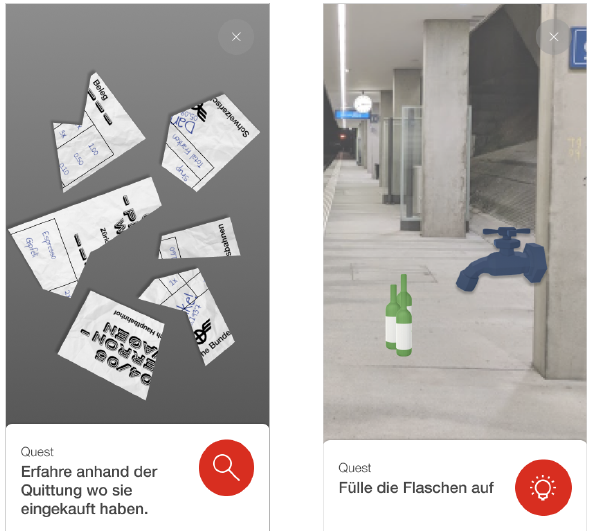
Figure 1. Sample quests. Left: 2D/AR quest “Find out where the receipt was from” , Right: AR/MR quest “Fill the bottle”